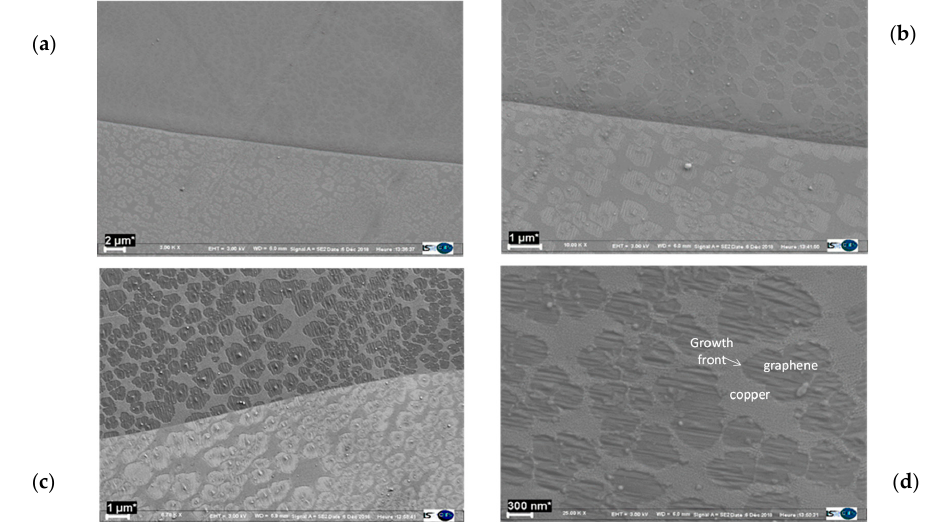
Figure 10. SEM images at different magnifications of graphene grown on copper foil after 5 s deposition time: (a) 5,000 X; (b) 6,780 X; (c) 10,000 X and (d) 25,000 X.